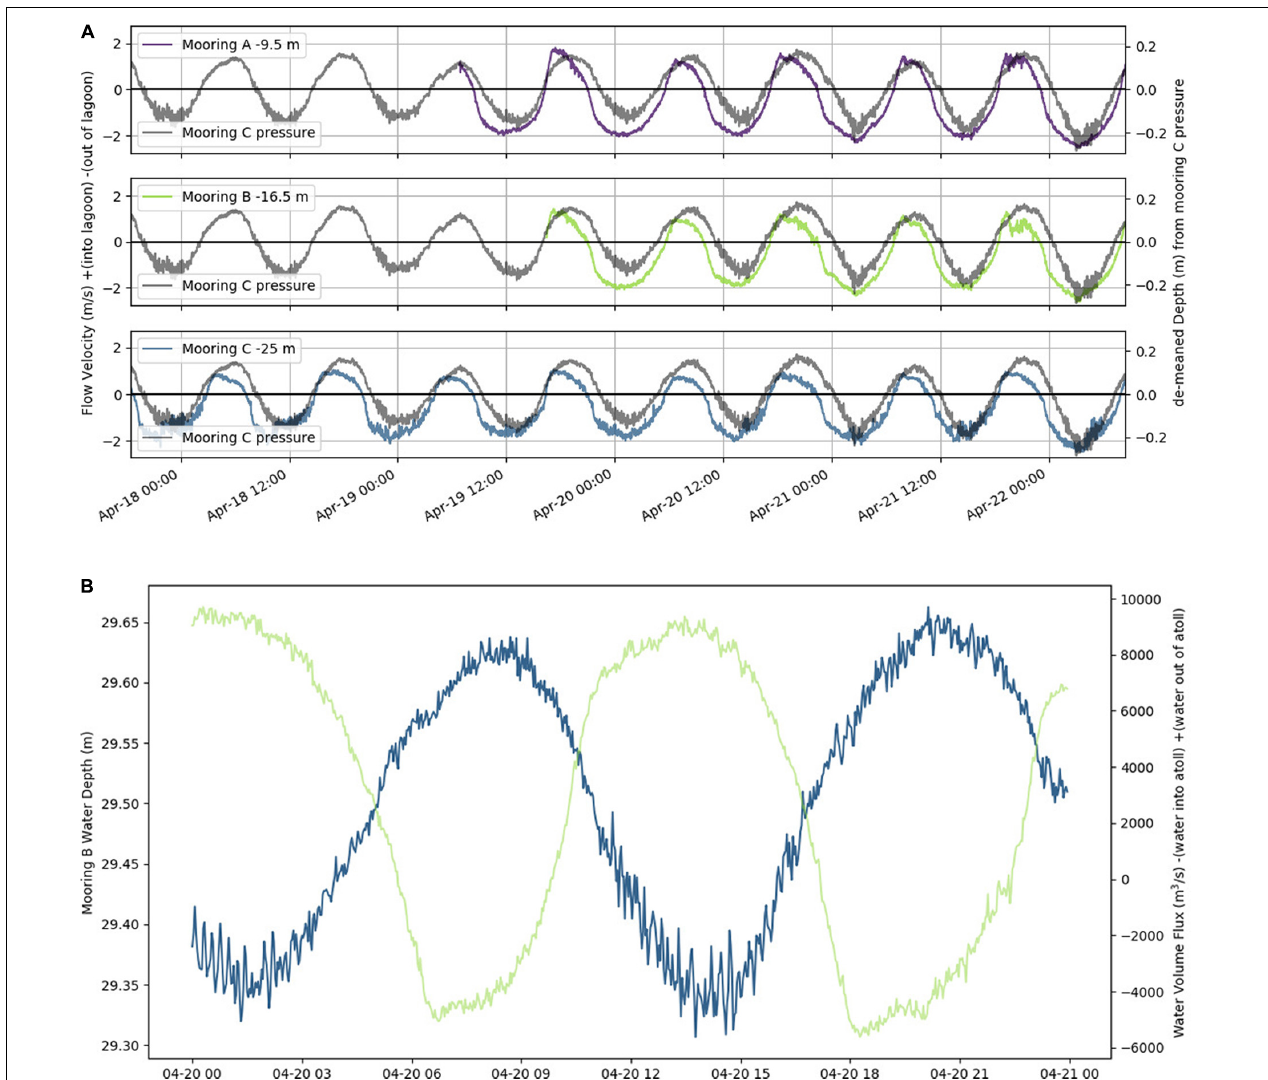
FIGURE 7 | (A) Horizontal channel flow at a single water depth plotted with a demeaned tide taken from pressure at mooring C (gray line in each panel in April 2014). Top panel is mooring A; flow is at 9.5 m depth (purple). Middle panel is mooring B; flow is at 16.5 m depth (green). Bottom panel is mooring C; flow is at 25 m depth (blue). Flow velocity is in m s - 1 . Relative water depth in m. (B) Water level (m, blue) and water flux (m 3 s - 1 , green) at mooring B over 24-h period on 20 April 2014. Negative water flux indicates water flowing into the lagoon, positive water flux indicates water flowing out of the